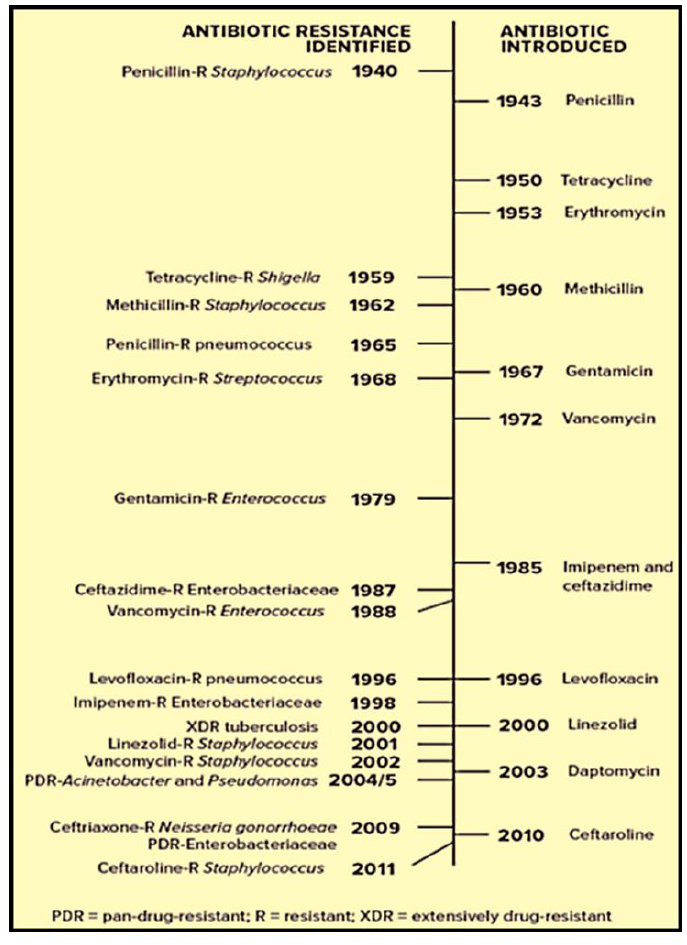
Figure 1. Timeline of events in the development of antibiotic resistance [23].